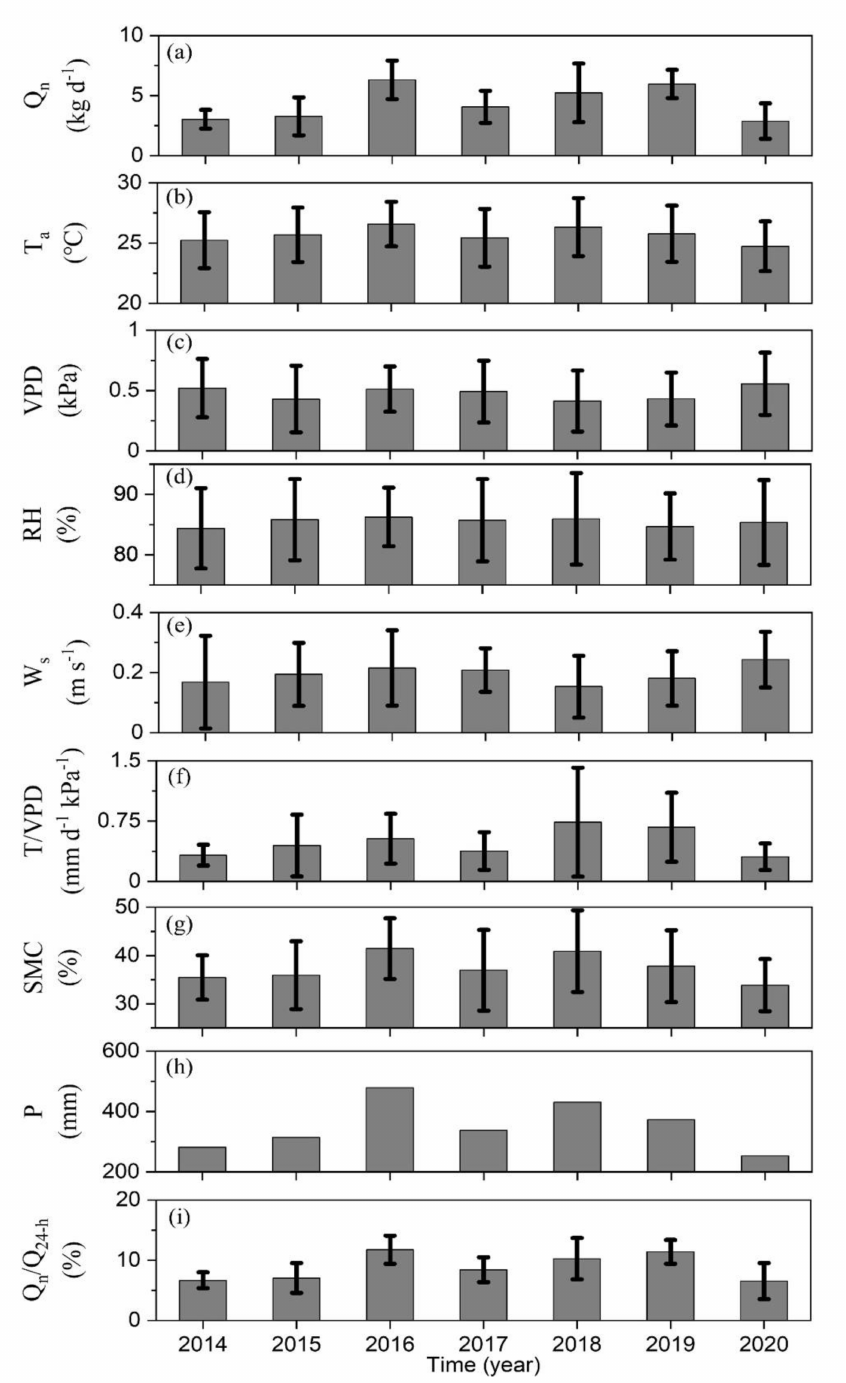
Figure 6. Interannual courses in nighttime growing season annual means of ( a ) sap flow rate (Q n ), ( b ) air temperature (T a ), ( c ) vapor pressure deficit (VPD), ( d ) relative humidity (RH), ( e ) wind speed (W s ), ( f ) canopy conductance (T/VPD), ( g ) soil moisture content (SMC), ( h ) total nighttime precipitation (P), and ( i ) ratio of nighttime sap flow to total 24-h sap flow (Q n /Q 24-h × 100) during 2014–2020. Error bars are given for annual mean of all the selected variables except total